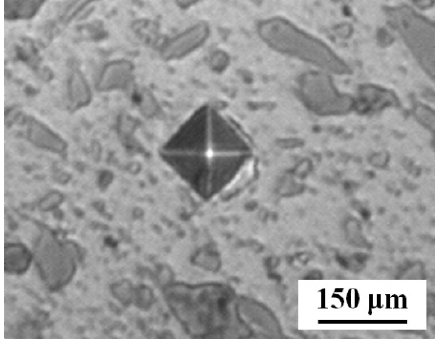
Figure 7. Optical microscopy image showing the indentation mark taken from the 50-h milled and hot pressed